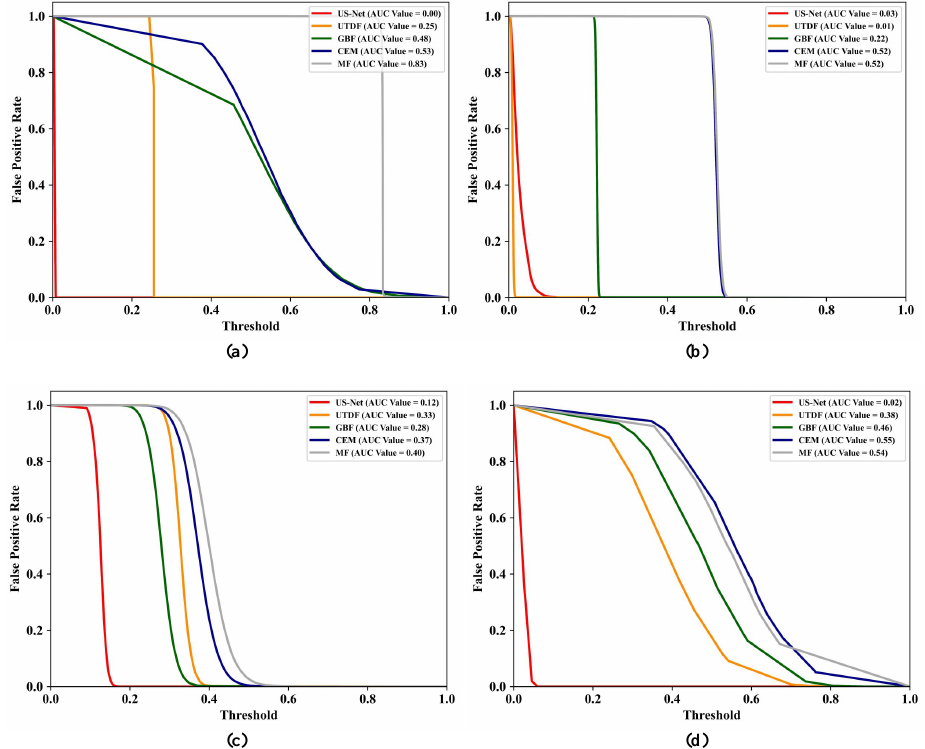
Figure 13. The ROC curves of ( P F , Threshold ) for the compared underwater target detection methods